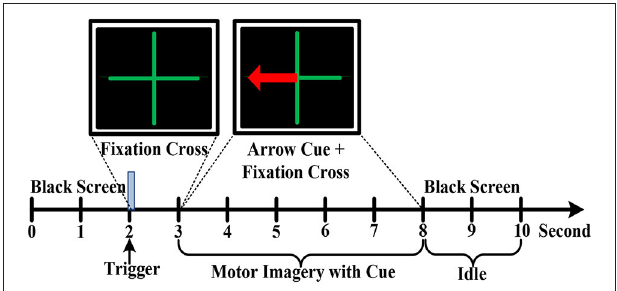
FIGURE 3 | The motor imagery EEG experimental paradigm.